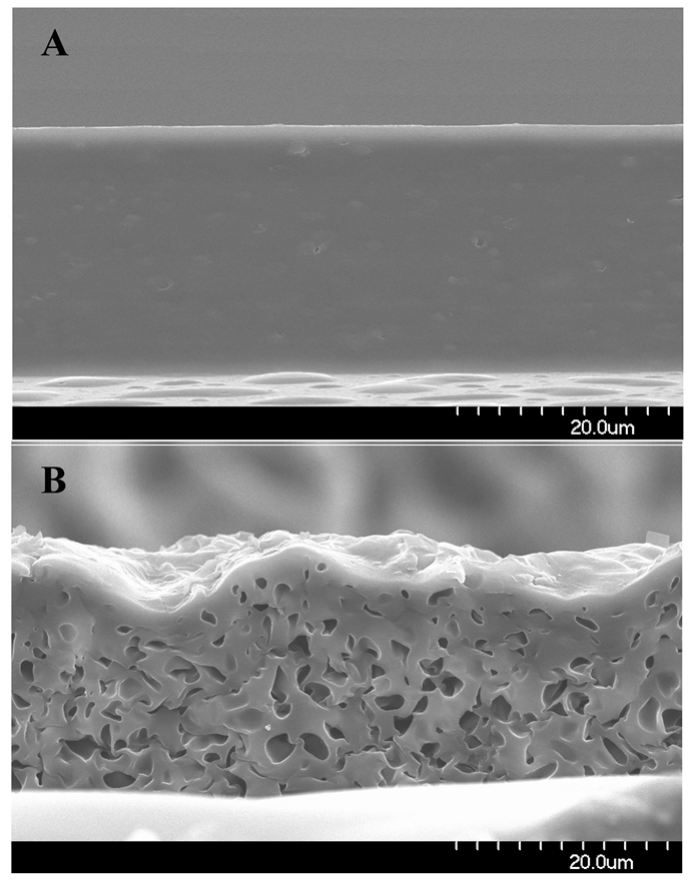
Figure 9. SEM images of 10GEM-10PGEM–PU film before ( A ) and after the release of gemcitabine ( B ) GEM and PGEM denote the clinical form and pure chemical form of gemcitabine, respectively. (Reprinted with permission from [37]. Copyright 2012 Editions de